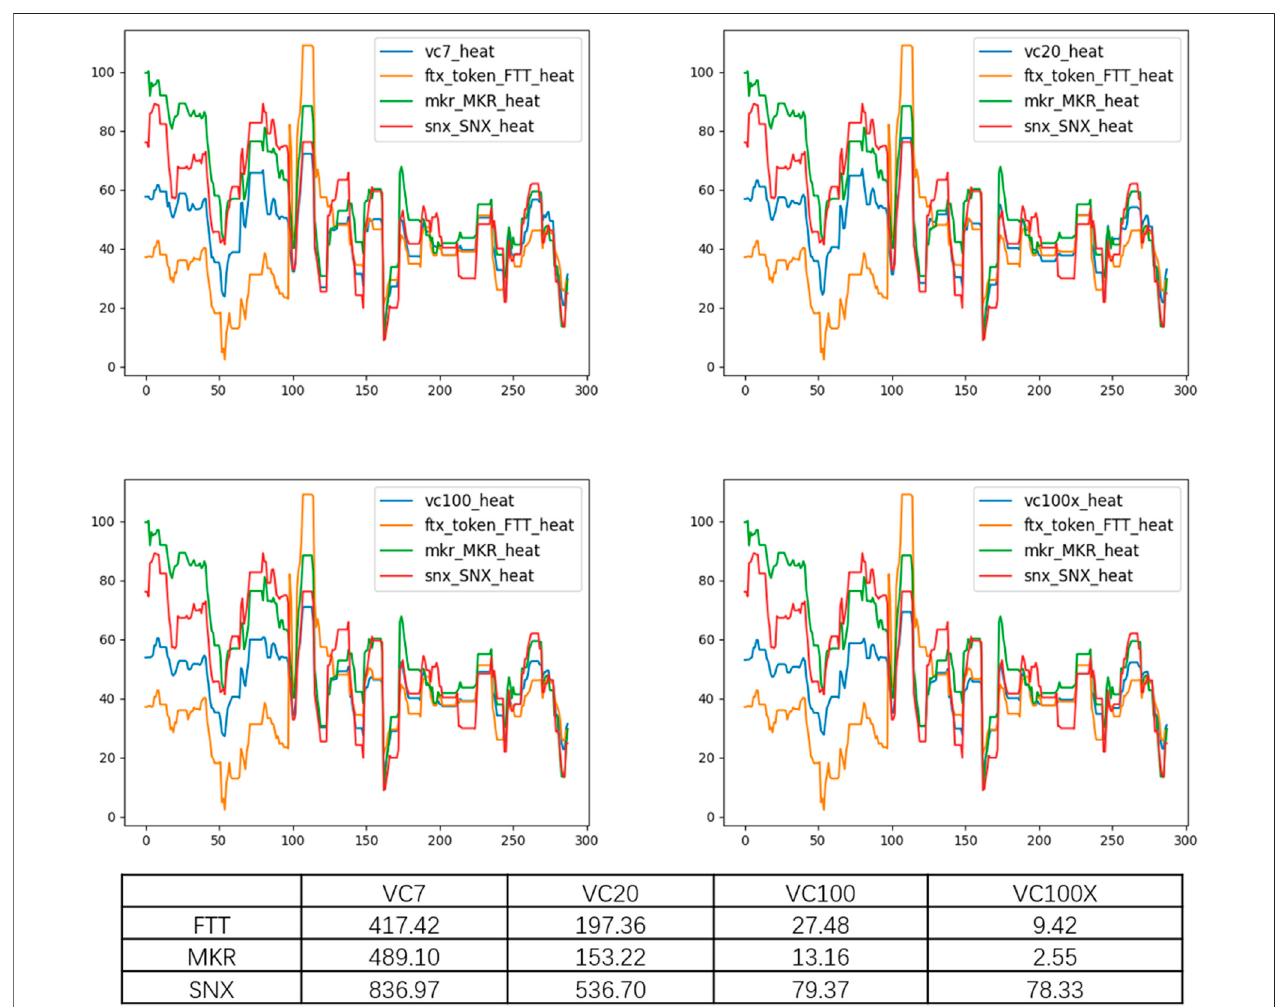
FIGURE 11 | FTT, MKR, and SNX popularity values compared with the four indexes on August 3.